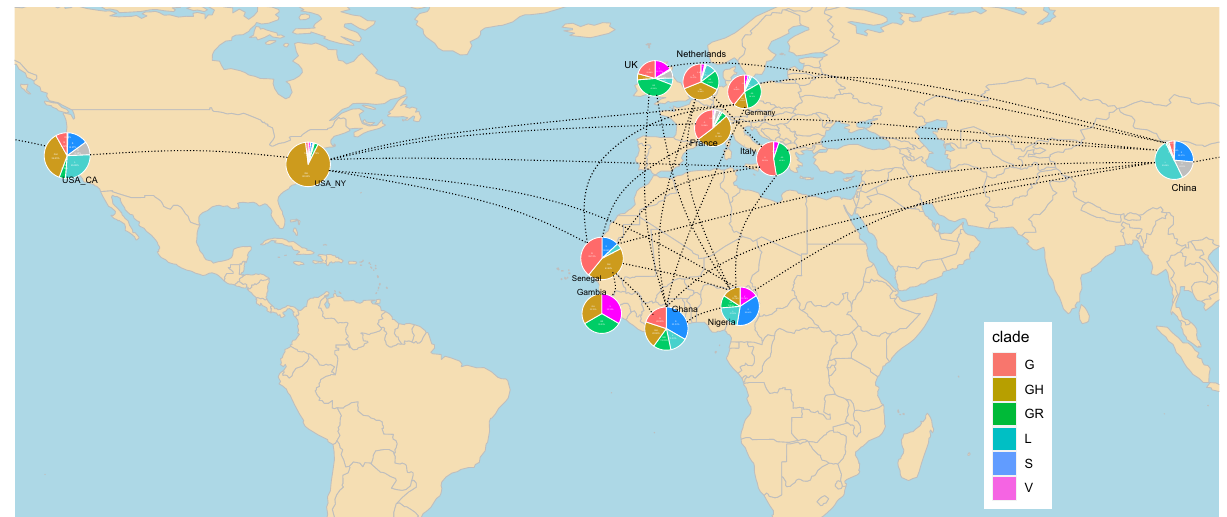
Figure 5. Geographic map reveals distinct patterns of introduction of China-and Europe-based clades in West African countries (until April 2020). Nigeria with the highest percentage of the China-based early clades (L, S, V) and Ghana with nearly equally distributed percentages of China and Europe-based clades (G, GH, GR) might be comparable with the US West Coast while Senegal with a similar clade distribution like France and few samples from the early China-based clades may be more comparable to the US East Coast. It will be interesting to observe if the later G clades replace the early clades in Nigeria and Ghana and if that correlates with the severity of the disease as was postulated for the US. The R package rworldmap (version 1.3-6, https:// cran.r- proje ct. org/ web/ packa ges/ rworl dmap/ index. html), South 32 was used to generate the world map in this figure